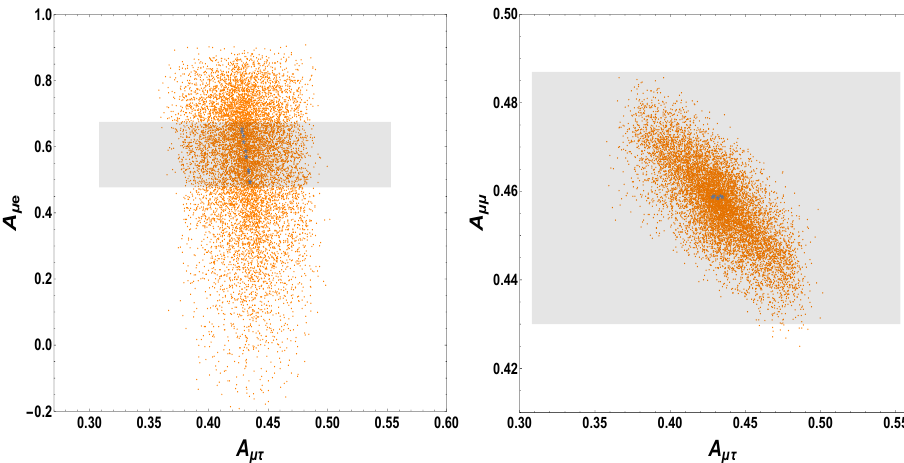
Figure 8. Same as Figure 7 but using the optimized flux.